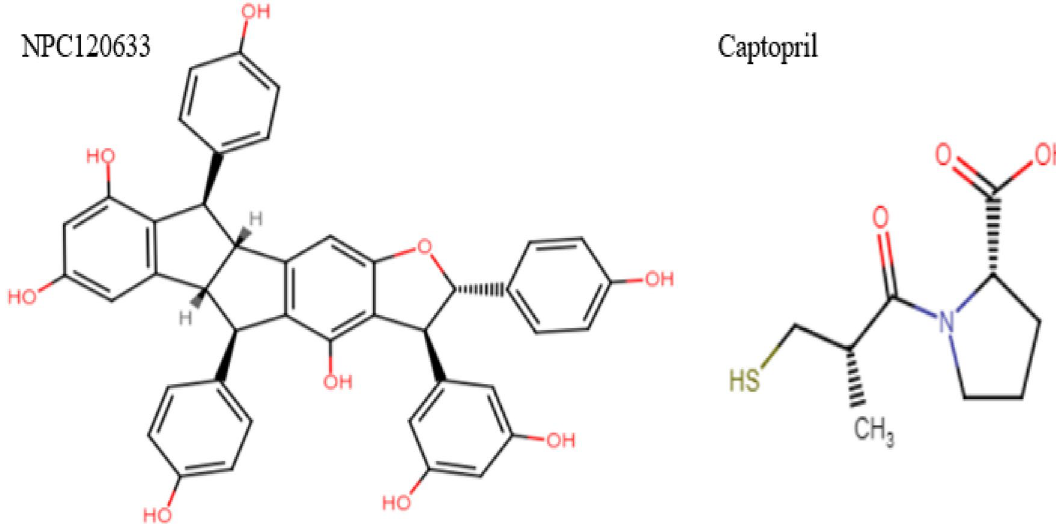
Figure 3. The structure of captopril and